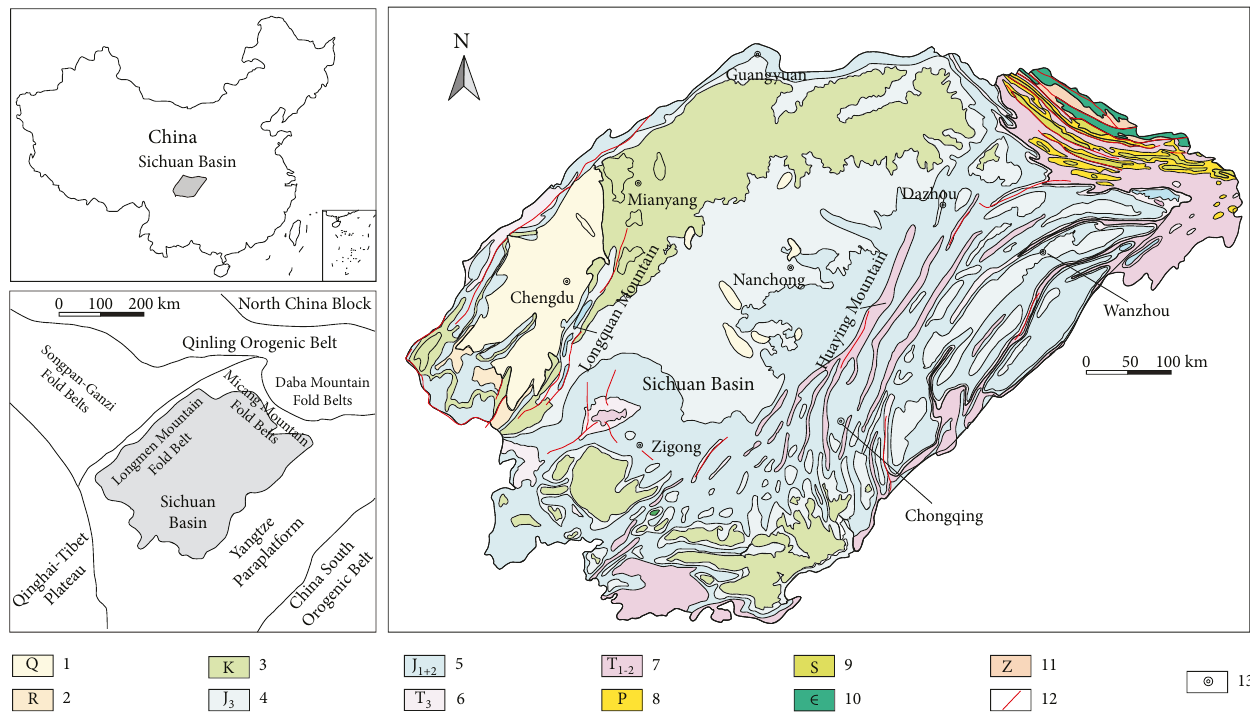
Figure 1: Simpli fi ed geological map of the Sichuan Basin (modi fi ed from the National Geological Map Database). 1: Quaternary sand and gravel; 2: Tertiary glutenite; 3: Cretaceous glutenite and mudstone; 4: Upper Jurassic sandstone and mudstone; 5: Middle and Lower Jurassic sandstone and mudstone; 6: sandstone and mudstone of the Upper Triassic Xujiahe Group; 7: carbonate of the Lower Triassic Jialingjiang Group and Middle Triassic Leikoupo Group; 8: Permian shale, killas, and tu ff ; 9: Siluria shale, killas, and mudstone; 10: Cambrian limestone and dolomite; 11: Neoproterozoic carbonate; 12: fault; 13: